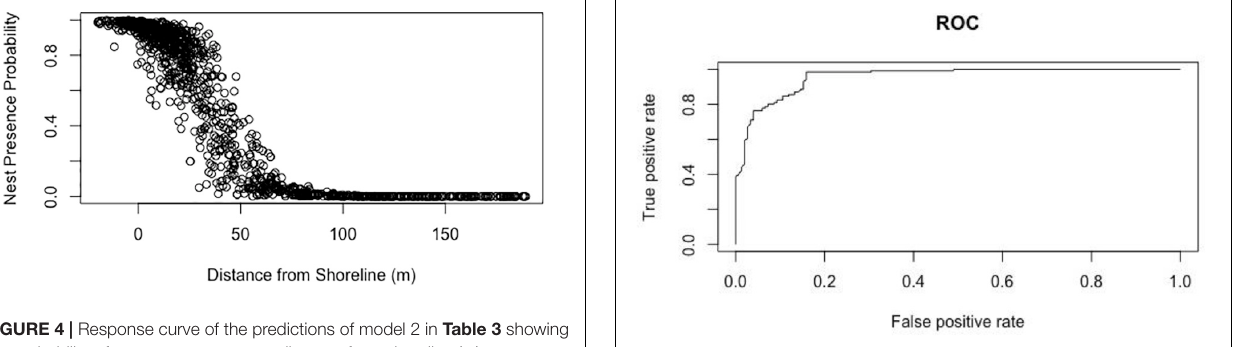
FIGURE 5 | Receiver operating characteristic (ROC) curve of the random forest model.